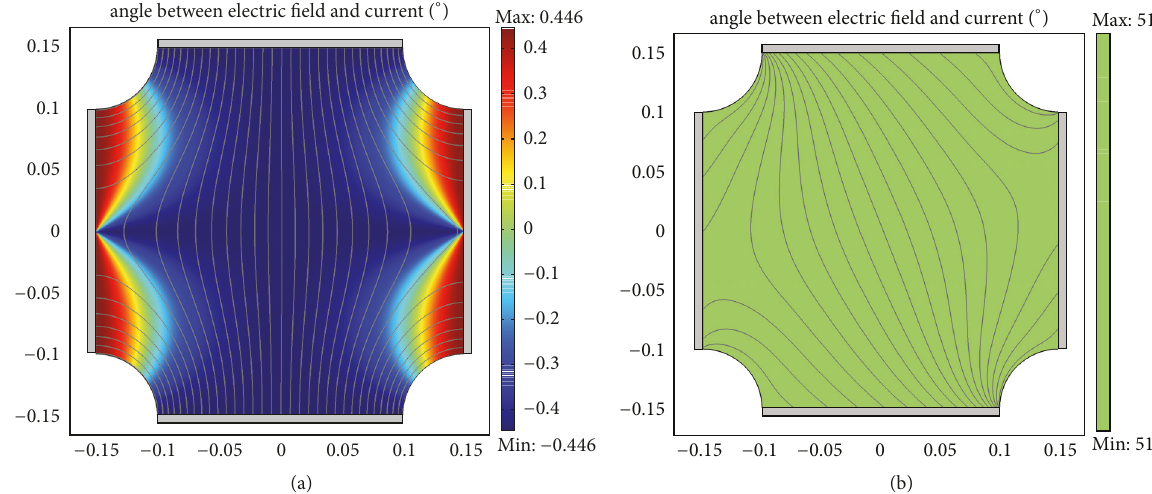
Figure 3: (a, b) Angle between electric field and current density in a device of Figure 2(b) operated like in Figure 2(b). The plots were obtained by FEM simulations with COMSOL MULTIPHYSICS. In (a) we have zero magnetic field and small mechanical stress (𝜋 12 − 𝜋 11 )𝜎 𝑥𝑦 = tan 0.446 ∘ . In (b) we have zero stress and even large magnetic field with 51.078 ∘ Hall angle. As predicted by [28] the Hall angle is perfectly homogeneousthroughoutthedevice(b),whereasinthepiezoresistivecase(a)theangle and in the major portion of the device and +0.446 ∘ at the sense contacts. Therefore the analogy [2] between Hall effect and piezoresistive effect does not apply in this case.